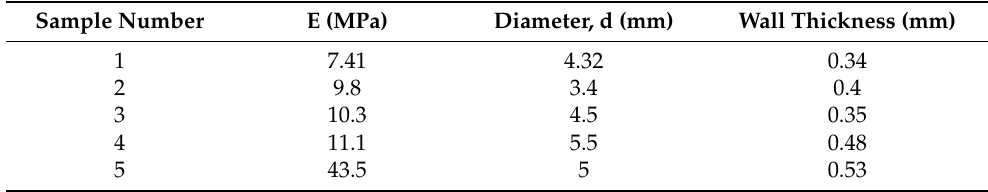
Table 2. Parameters of samples used in the study.